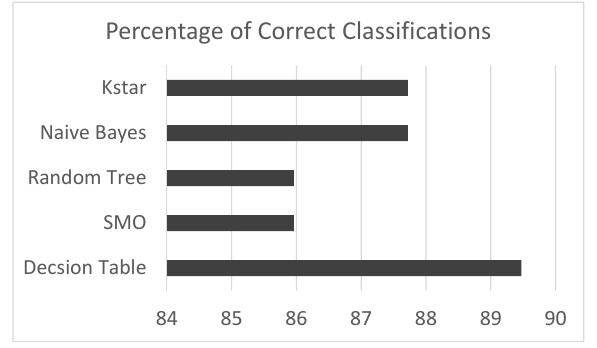
Figure 9. Percent of correctly classified instances for different classifier using 66 % of the dataset as the training set - from a total of 57 instances